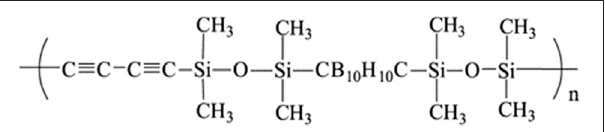
FIGURE 2 | Chemical structure of PACS.